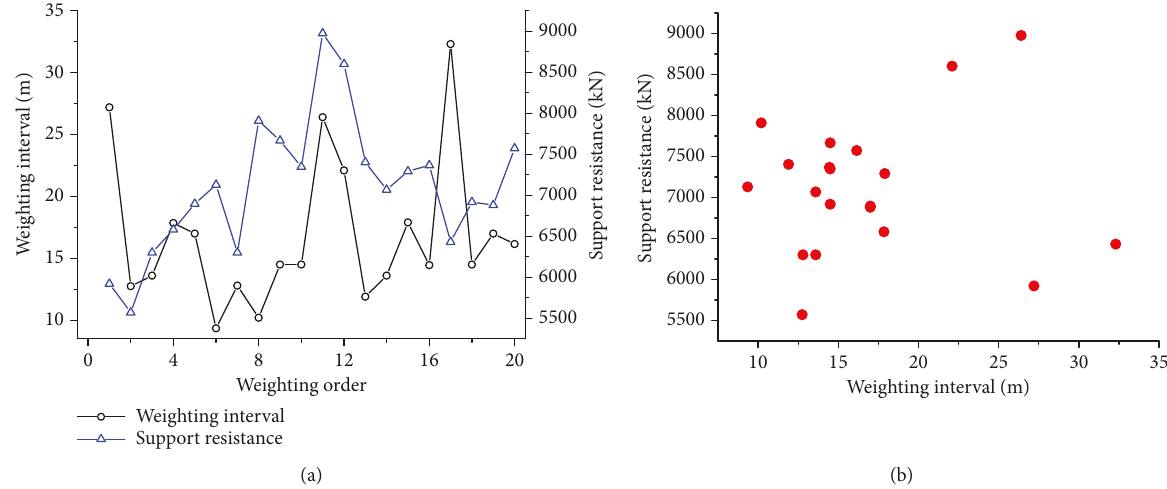
Figure 3: Strata behaviours of the working face. (a) Weighting order. (b) Weighting interval-support resistance.